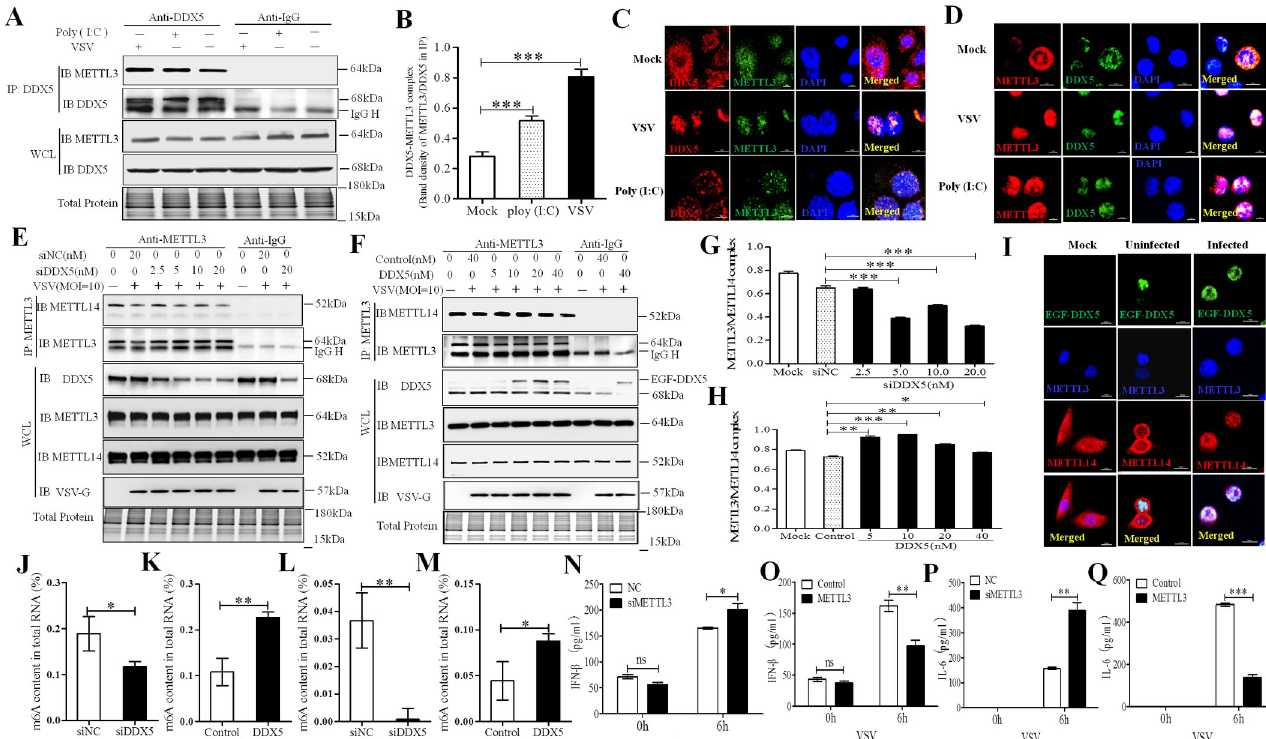
Fig 3. DDX5 regulated the m6A writer complex by recruiting METTL3 after VSV infection. (A, B): VSV promoted the interaction of DDX5 and METTL3 in MEFs. MEFs were infected with VSV or treated with Poly (I:C) for 8h and lysed with NP40 lysis buffer. Lysates were subjected to IP with DDX5 antibody or IgG. Whole-cell and IP lysates were analyzed by western blotting. The DDX5-METTL3 interaction complex was quantified by the western blot band density of METTL3/ DDX5 of IP lysates. (C, D): Co-localization of DDX5 and METTL3 in MEFs (C) or macrophages (D) after VSV infection. MEFs/macrophages were cultured in slices and transfected with VSV or treated with Poly (I:C) for 8h. Slices were fixed, permeabilized, and incubated with rabbit anti-DDX5 and mouse anti-METTL3 antibodies followed by Alexa Fluor 546 labeled goat anti-rabbit IgG and Alexa Fluor 488 labeled goat anti-mouse IgG. Nuclei were stained with DAPI. Cells were observed by LSCM. Scale bars, 10 μ m. (E, F): The interaction of METTL3 and METTL14 in DDX5-knockdown MEFs (E) or enhanced green fluorescent (EGF) tag fused DDX5-overexpressed MEFs (F). MEFs were transfected with different doses of DDX5 siRNA (siNC) for 48 h (E) or with different doses of EGF-DDX5 expression plasmids (control vector) for 24 h. Cells were infected with VSV (MOI = 10) for 8 h and lysed with NP40 lysis buffer, lysates were subjected to IP with rabbit METTL3 antibody or IgG. Whole-cell and IP lysates were analyzed by western blotting. (G, H): METTL3-METTL14 complex was quantified based on band intensity on western blot, METTL14 was normalized to METTL3 in IP assay, METTL3-METTL14 complex was determined in DDX5 knockdown IP assay ( E )or DDX5 over-expressed IP assay ( F ). I: Co-localization of exogenous DDX5, METTL3, and METTL14 in VSV-infected MEFs. MEFs were cultured in slices and transfected with EGF-DDX5 expression plasmids. After 24 h, cells were infected with VSV for 8h; then, slices were fixed, permeabilized, and incubated with rabbit anti-METTL3 and mouse anti-METTL14 antibodies followed by goat anti-mouse IgG (H+L) highly cross-adsorbed secondary antibody, Alexa Fluor 647, goat anti- rabbit IgG (H+L) secondary antibody, and DyLight 405. Nuclei were stained with DAPI. Normal MEFs were used as controls. Slices were observed by LSCM. Scale bars, 10 μ m. (J, K): The m6A content in total RNA was detected in DDX5-silenced MEFs ( J )or DDX5-expressing MEFs ( K )after VSV infection by ELISA. MEFs were transfected with DDX5 siRNA for 48h ( J )or DDX5 expression plasmid for 24 h (K). Cells were infected with VSV for 8 hours used to detect m6A content in total RNA using anm6A RNA Methylation Assay Kit. (L, M): The m6A content in total RNA was detected in DDX5-silenced macrophages ( L )or DDX5-expressing macrophages ( M )after VSV infection by ELISA. Macrophages were infected with ADV1-siDDX5 ( L )or lentiviral DDX5 for 48 h ( M ).Cells were infected with VSV for 8h and used to detect the m6A content in total RNA using anm6A RNA Methylation Assay Kit. (N, O): ELISA analysis of IFN- β in the supernatants of METTL3-knockdown or–overexpressed MEFs infected with VSV for 0 or 6 h. ( P, Q): ELISA analysis of IL-6 in supernatants of METTL3-knockdown or -overexpressed MEFs infected with VSV for 0 or 6 h. All data are mean ± SEM of biologically independent samples. Data are representative of three independent experiments. ns, no significant difference. � p < 0.05, �� p < 0.01, ��� p < 0.001(Student’s t